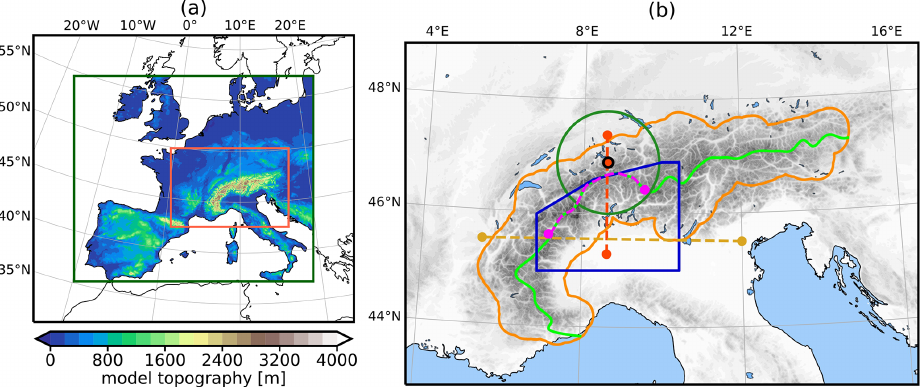
Figure 1. (a) Domains and topography of the COSMO-7 (green) and the COSMO-1 (red) analyses, respectively. (b) Polygon around the Alps and the crest line (dark orange and lime). Altdorf is highlighted by a red dot with a black edge. Further indicated are a circle for the wind feature extraction (green) and a polygon for the precipitation feature extraction (dark blue). The cross-Alpine cross section, the along-crest cross section and the upstream Po Valley cross section are marked as dashed red, pink and golden lines,